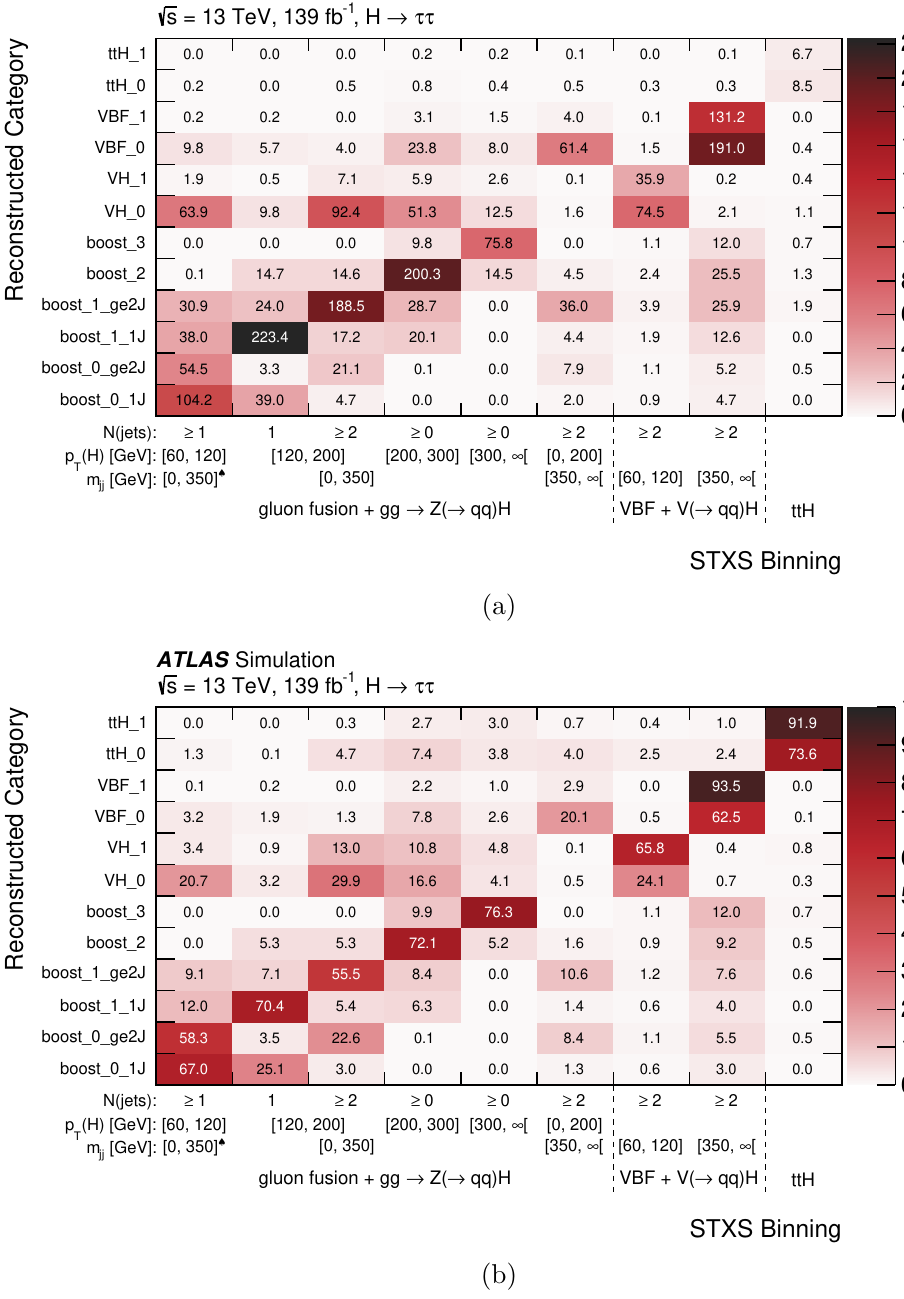
Figure 2. (a) Expected H → ττ signal yield in each of the reconstructed-event categories of the analysis ( y -axis) for each of the nine measured STXS bins ( x -axis). (b) Relative contribution of each of the nine measured STXS bins to the total H → ττ signal expectation in each reconstructed-event category. The spades symbol ( ♠ ) indicates that the criteria for m two reconstructed jets. Yields are summed over the three ττ decay channels ( τ